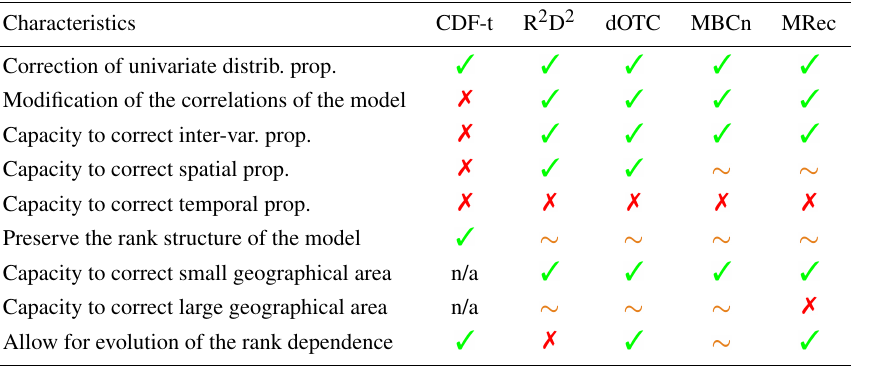
Table 2. Summary of recommendations for the multivariate BC methods to use with respect to the different assumptions made by practition- ers or end users. Green checks and red crosses indicate whether BC methods are recommended for use or not, depending on the statement in rows. Orange tildes indicate when particular caution has to be taken. Not-applicable (n/a) is indicated when the statement in rows does not